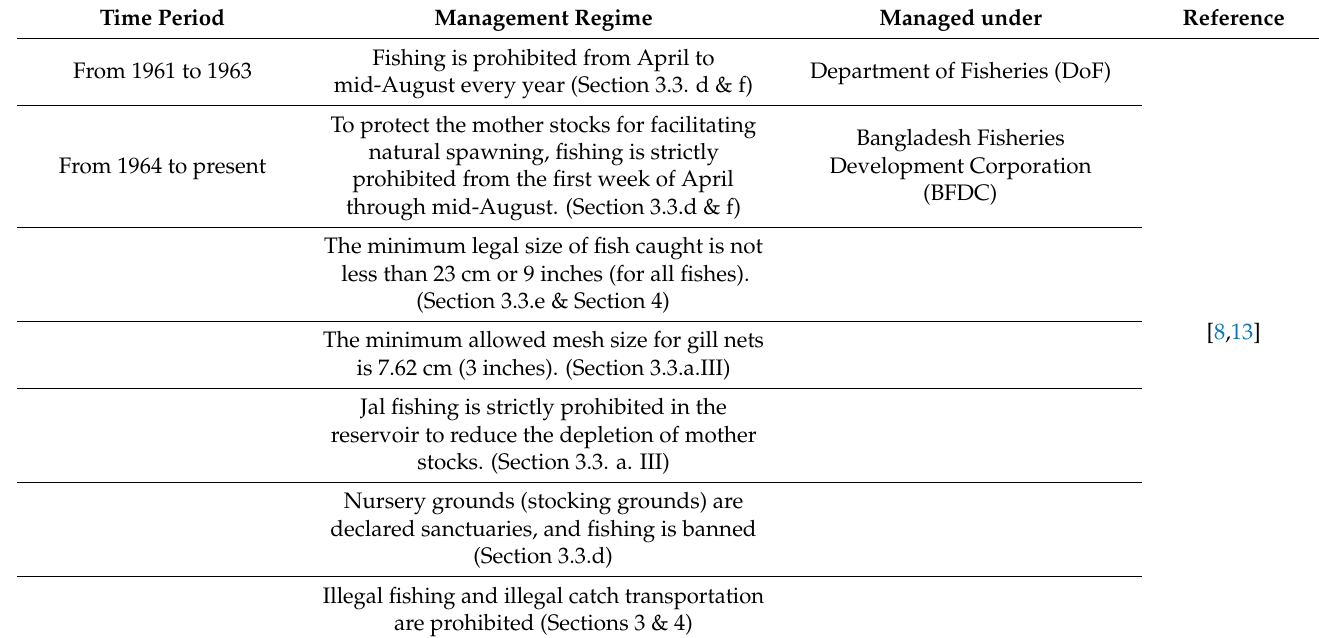
Table 3. Management in place under the Fish Act 1950 in the Kaptai Lake.